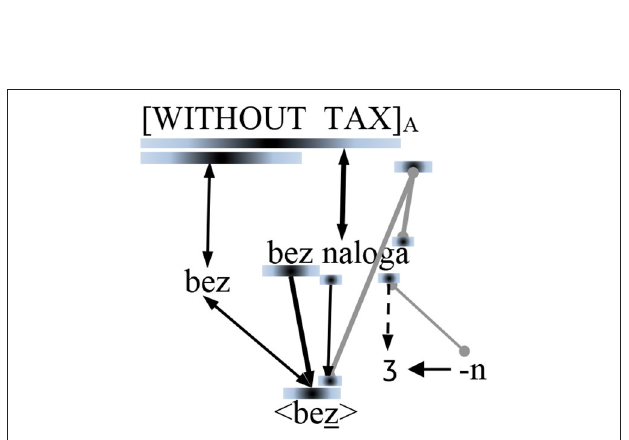
FIGURE 3 | Phonological and orthographic aspects of producing beznalo3nyj . Paradigmatic association in dashed line.